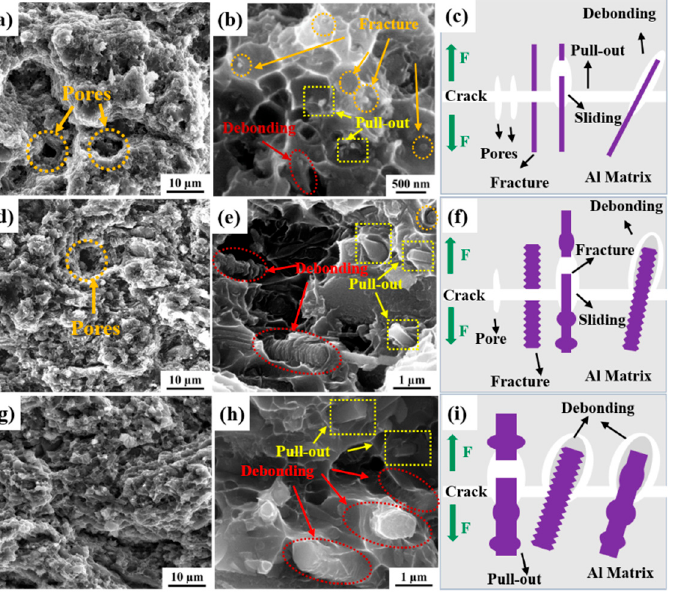
Figure 12. Fracture morphology of SiCnw/6061Al composites prepared by SiCnws with different diameters. ( a , b ) 100 nm, ( c ) Schematic corresponding to ( a – d ) 250 nm, ( f ) Schematic corresponding to ( d , e ), ( g , h ) 450 nm, ( i ) Schematic corresponding to ( g , h